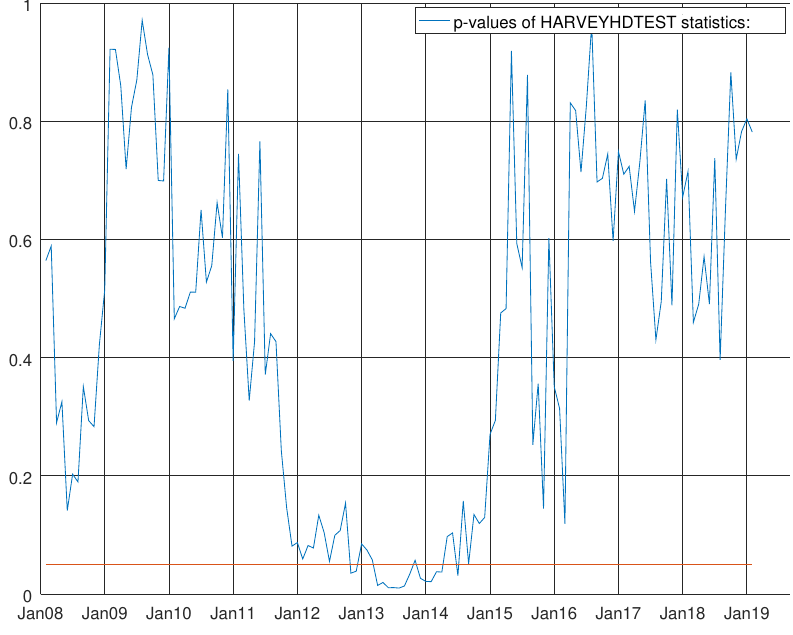
Figure 7. Graph showing the p -values of the Harvey heteroskedasticity test for the VARMA model using the hard data only. The null hypothesis states that the residuals are not